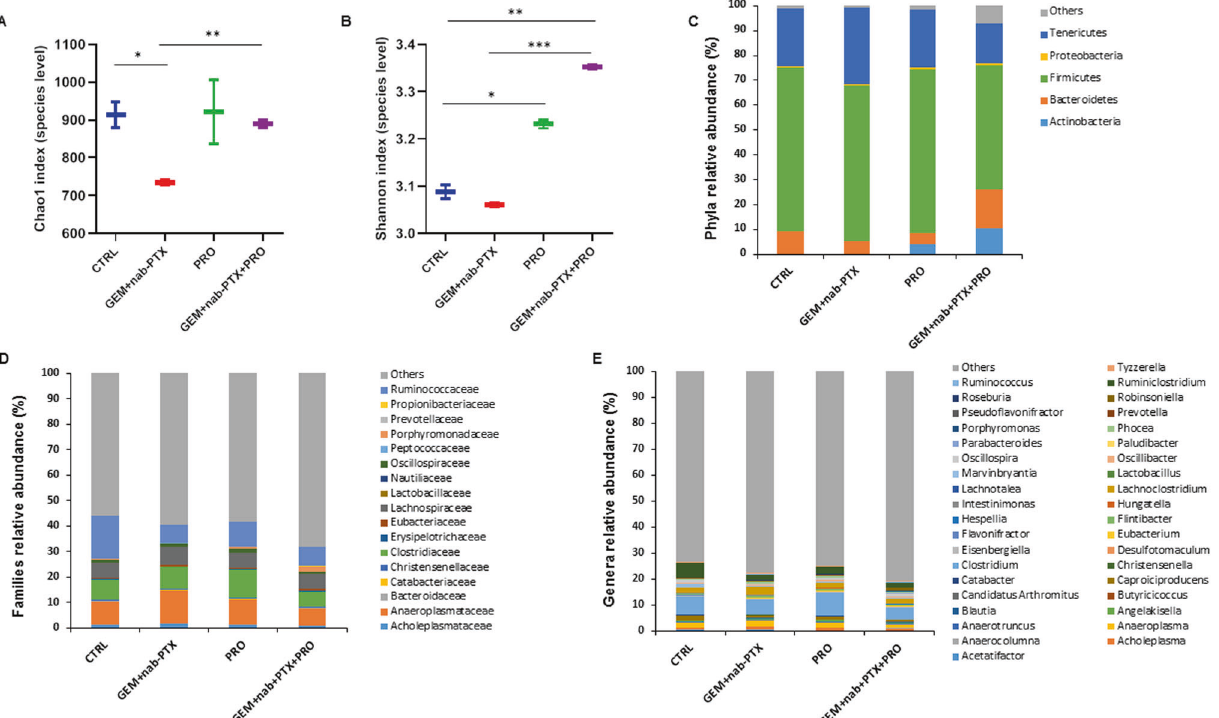
Fig. 5 Effect of chemotherapy and/or probiotic treatment on gut microbiota alpha-diversity and taxonomic composition in BxPC-3 bearing mice. Boxplots representing species-level richness expressed by Chao1 index ( A ) and diversity expressed by Shannon Index ( B ) in the four experimental groups. Data are expressed as means of two fecal pools per group. Differences were considered signi fi cant when * p < 0.05, ** p < 0.01, or *** p < 0.001. Stacked barplots showing the mean relative abundance of gut bacterial phyla ( C ), families ( D ), and genera ( E ) level. Data are expressed as means of two fecal pools per experimental